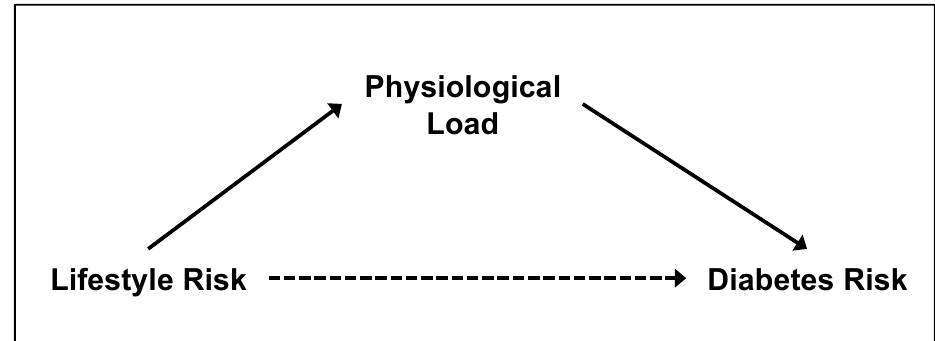
Figure 1. Illustration of the hypothesized pathways between Lifestyle Risk, Physiological Load and Diabetes Risk. Lifestyle Risk has a positive but indirect effect on Diabetes Risk through the mediator of Physiological Load. Note: Straight line with one arrowhead denotes positive and direct effect; dashed line with one arrowhead denotes positive but indirect effect.